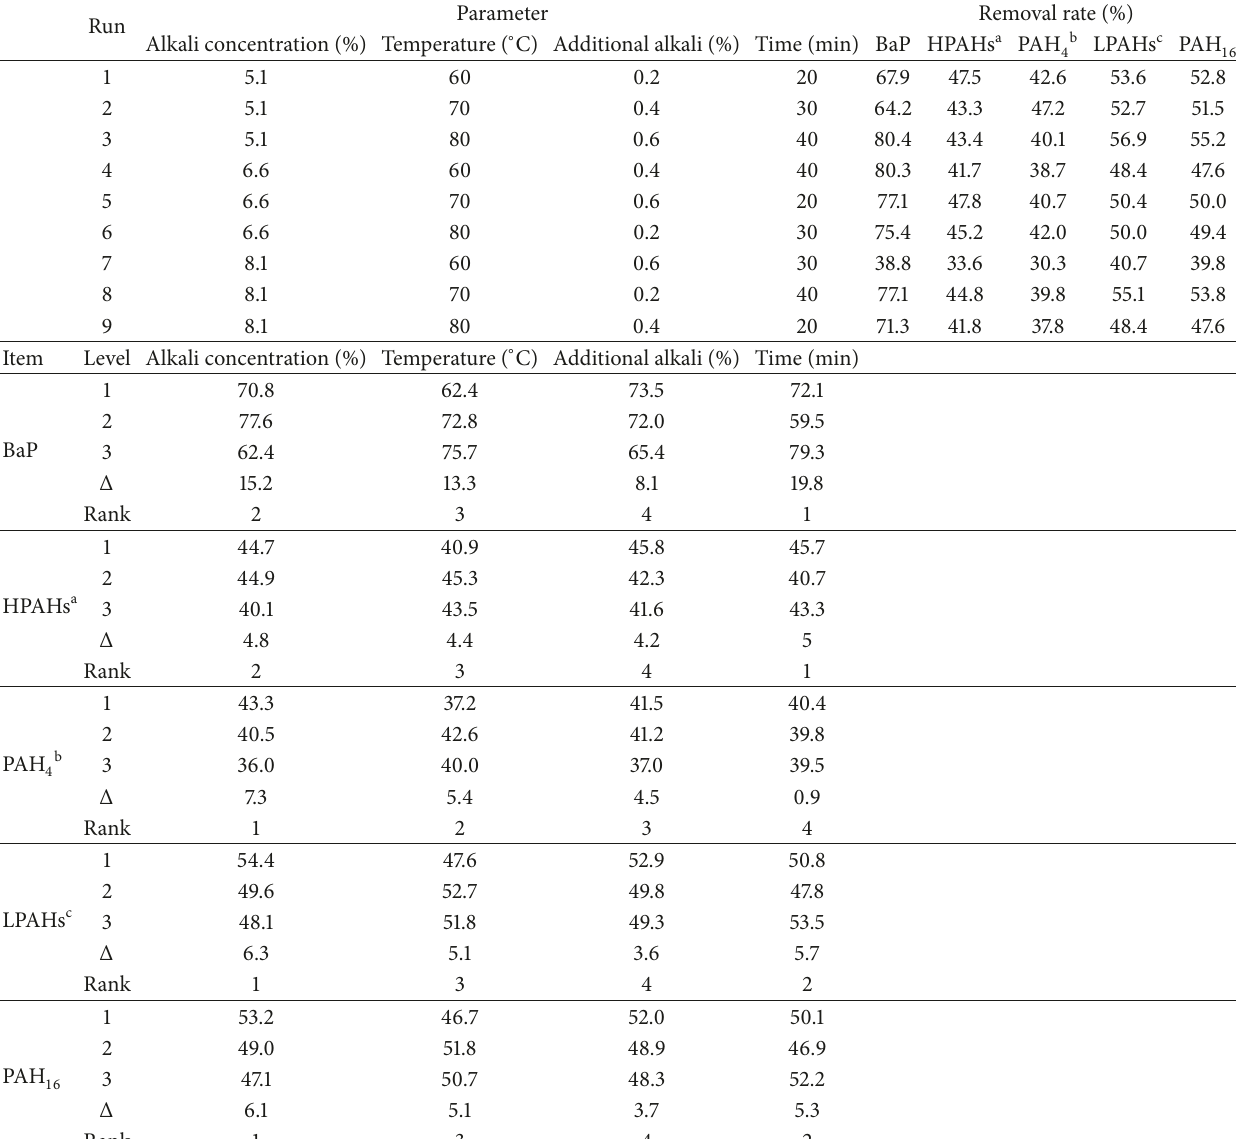
Table 2: Results of neutralization on